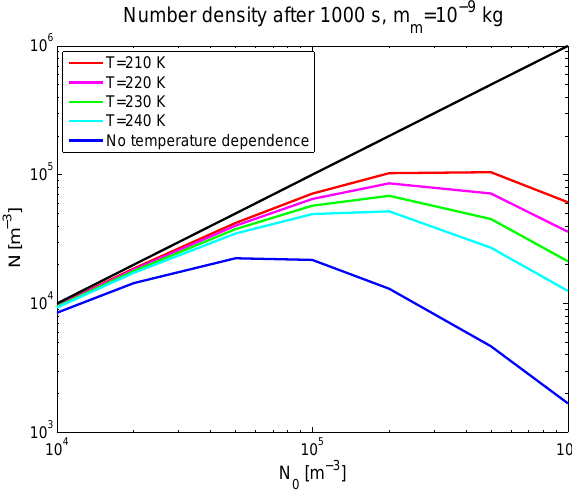
Fig. 4. Particle number density N 0 at the start of the iteration (x- Axis) and after 1000 s of iteration ( N , y-Axis). For small modal masses, the particle number density hardly changes during the iter- ation and the plot is almost a straight line. As reference for no ag- gregation, a black line is plotted. As expected, larger modal masses result in increased aggregation. Thus the particle number density decreases during integration, which is shown in the graph. The cor- responding size to the modal masses plotted ranges between 6 and 345 µ m. Note that the tests have been performed with E ≡ 1 , that is, the maximum effect of aggregation is seen here. The red line is almost equal to the black line, thus can hardly be seen in the plot.